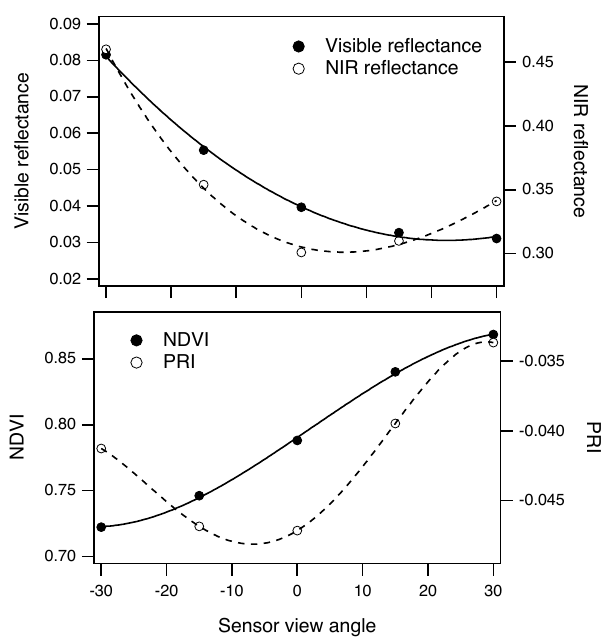
Figure 7. Angular response of several optical vegetation indices, including visible or near-infrared (NIR) reflectance (top panel), the NDVI, and the PRI (bottom panel). Data from a barley ( Hordeum vulgare L.) field in Edmonton, Alberta (Canada), at solar noon on 24 July 2009 using a UniSpec DC (PP Systems, Amesbury, MA, USA) mounted on a tram system (Fig. 6c). Each point is a mean of 52–74 samples collected along a 50m track (running E–W) within 30min of solar noon. Sensor view angle was measured in the solar principal plane. The backscatter direction (looking away from the midday sun) is indicated by negative sensor view